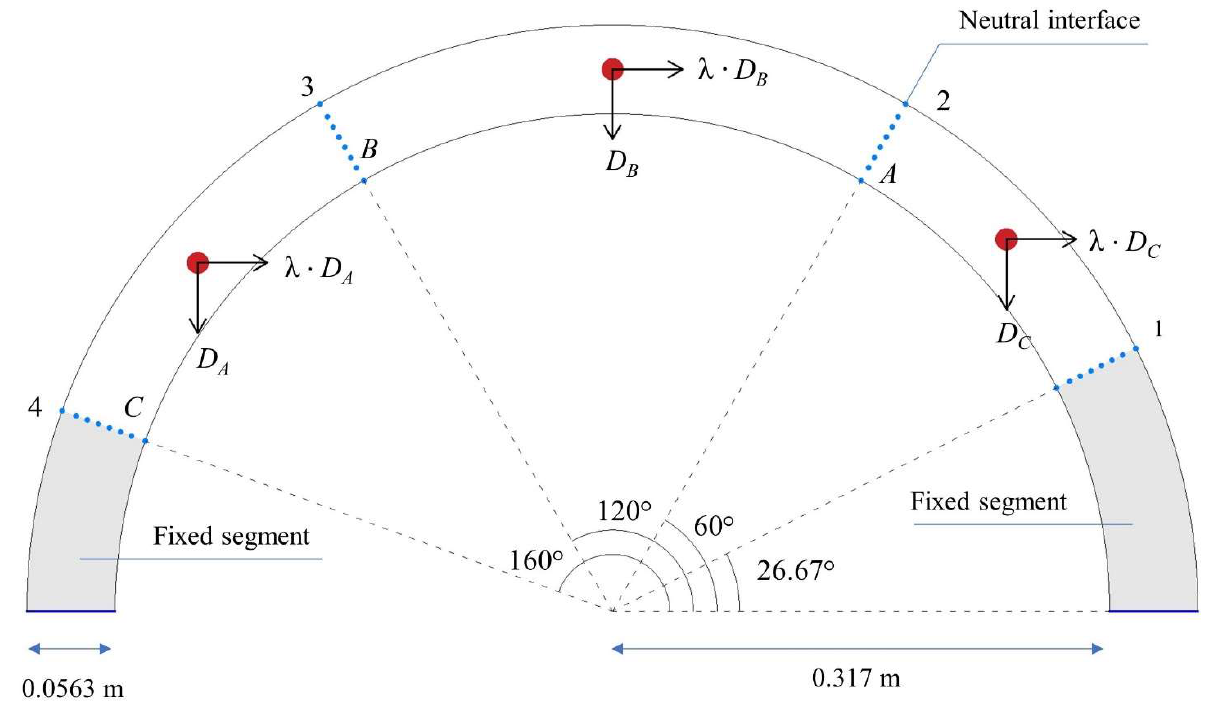
Figure 11. Semi-circular arch as originally presented by Stockdale et al. [64].